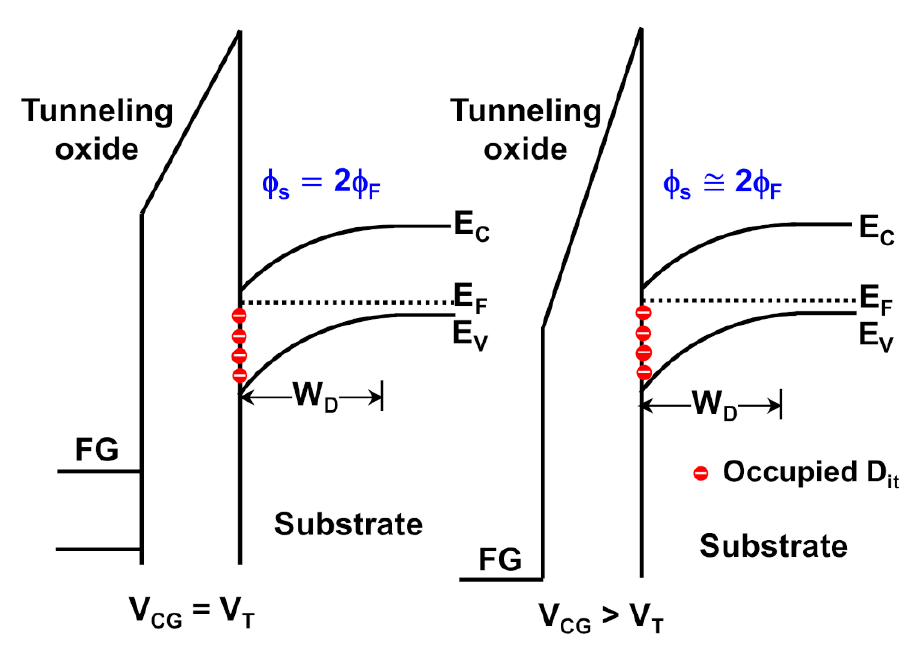
Figure 8. Band diagram and trap occupation of interface trap states at different biases. Reprinted from